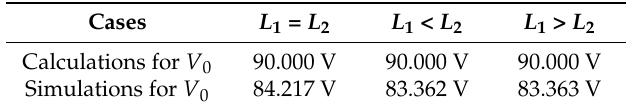
Table 6. Comparisons of the output voltage V 0 between the calculations and the saber simulations.